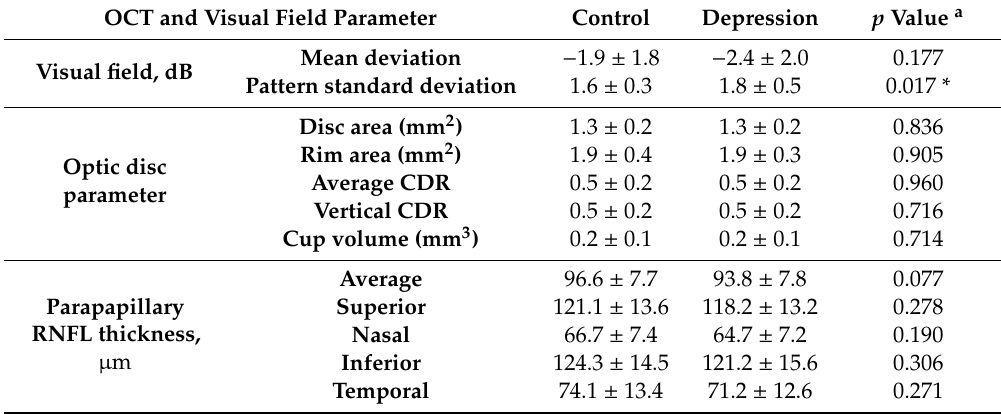
Table 2. Visual field parameters, parapapillary retinal nerve fiber layer thickness, and ganglion cell–inner plexiform layer thickness in subjects with and without